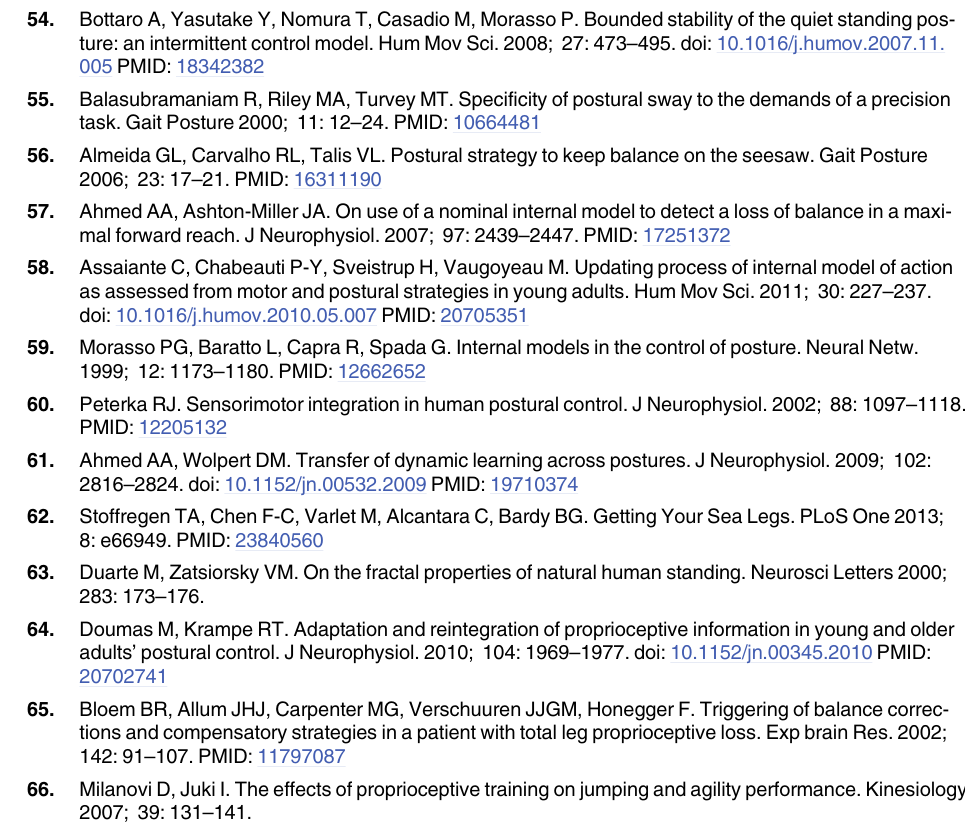
PLOS ONE | DOI:10.1371/journal.pone.0142423 November 6,